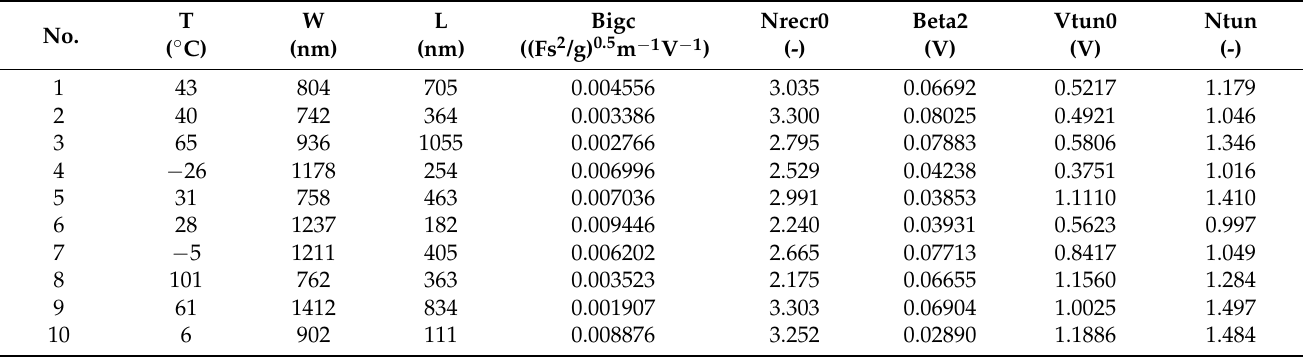
Table 3. Ten sets of